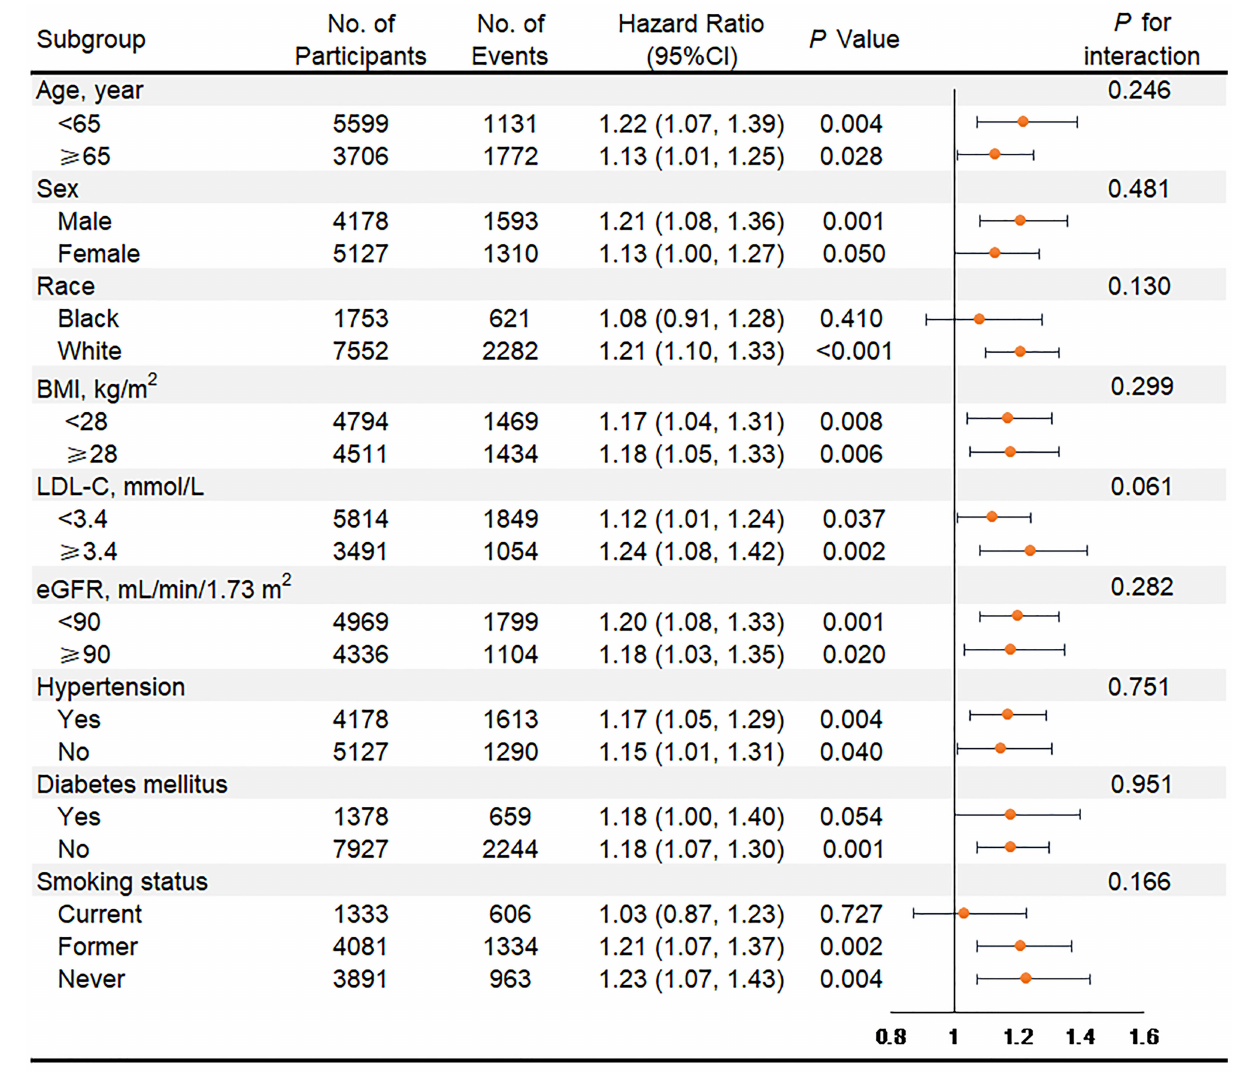
FIGURE 3 | Association of the highest quartile of MAP variability group (VIM Q4) compared with the lower MAP variability group (VIM Q1 + Q2 + Q3) for all-cause mortality in key subgroups. Hazard ratios and 95% CIs were obtained after individually removing the original variable from the Cox Model 3 that adjusted for age, sex, race, BMI, education level, smoking status, drinking status, total cholesterol, LDL-C, HDL-C, triglyceride, fasting glucose, eGFR, prevalent hypertension, diabetes mellitus, coronary heart disease, myocardial infarction, stroke, antihypertensive medicine, aspirin, statin, SBP, DBP at visit 4, and mean of MAP from visit 1 to 4. MAP, mean arterial pressure; VIM, variability independent of the mean; BMI, body mass index; LDL-C, low-density lipoprotein cholesterol; HDL-C, high-density lipoprotein cholesterol; eGFR, estimated glomerular filtration rate; SBP, systolic blood pressure; DBP, diastolic blood